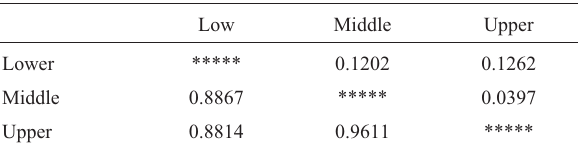
Table 3 - Nei’s (1978) genetic distance (above diagonal) and genetic identity (below diagonal), with Lynch and Milligan correction (1994), between A. altiparanae samples from the lower, middle and upper Paranapanema